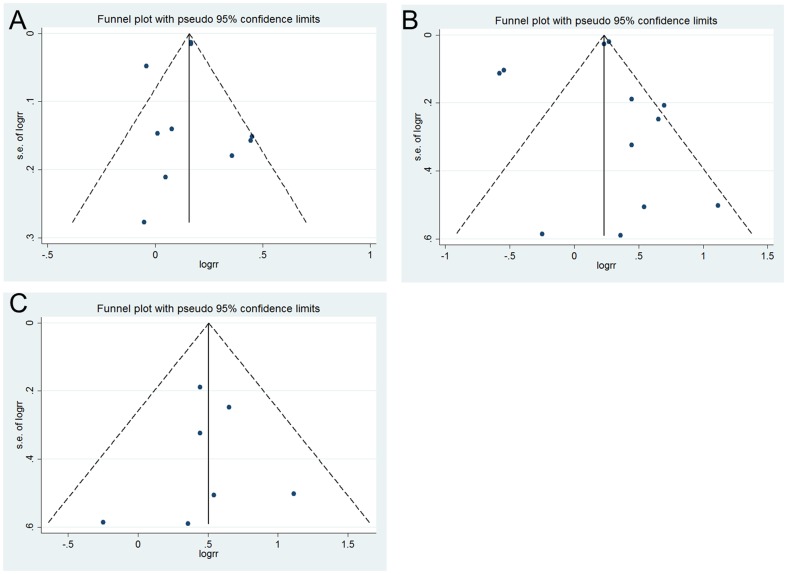
Funnel plots for the detection of public bias among studies that evaluated the associations of AMD with total CVD.The vertical line across the X-axis is the log of the pooled RR. Dotted lines are pseudo 95% CIs corresponding to a given standard error. Each dot represents one identified study. A symmetric distribution of dots around the vertical line indicates minimal publication bias. Figure 3A, early AMD with CVD. Begg's test, p = 0.93; Egger's test, p = 0.81; Figure 3B, late AMD with CVD. Begg's test, p = 0.73; Egger's test, p = 0.62; Figure 3C, late AMD with CVD among prospective studies. Begg's test, p = 0.76; Egger's test, p = 0.86.